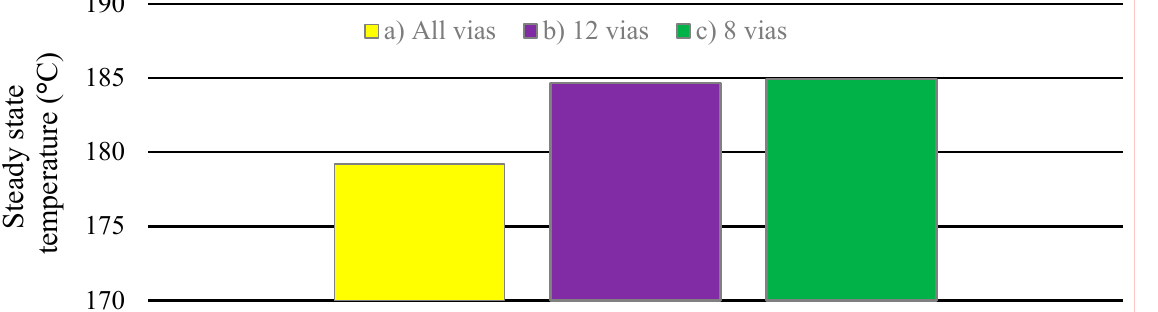
Figure 14. The regular PCB geometry with marked extension. Temperature transient of the hotspot (SP3) for different board sizes.